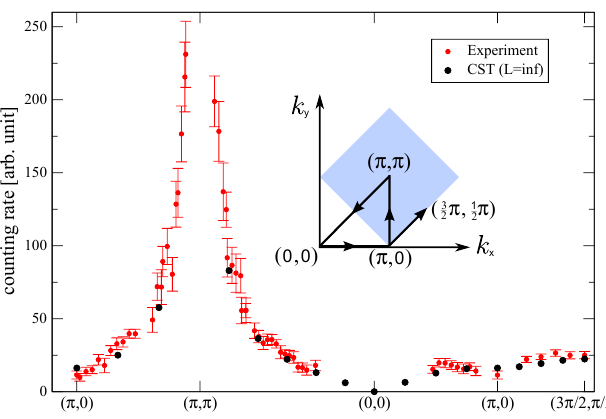
Figure 3: Transversal spectral weight of the single magnon excitations. Comparison of the measured weights from Ref. [ 15 ] with the computed weights S xx transversal SSF, see Eq. (15). An overall proportionality factor is